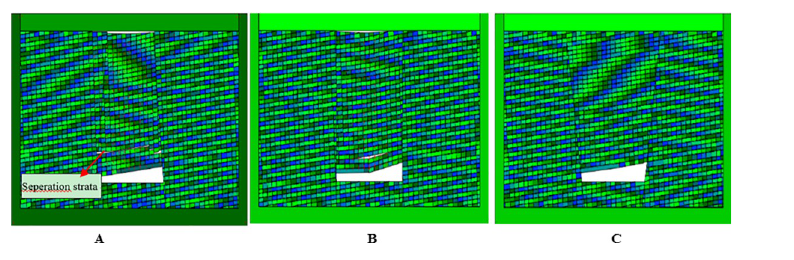
Fig 13. Simulated operation at 2400 time step. (A) Inverted funnel. (B) Columnar. (C) Funnel.